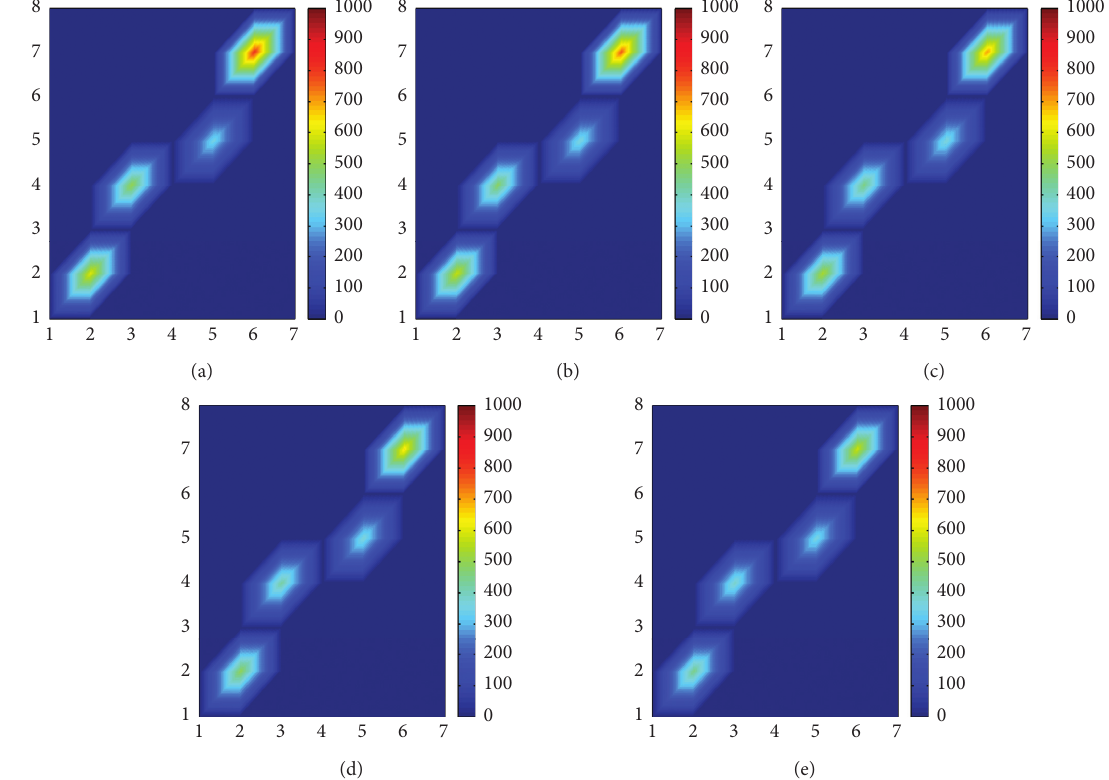
Figure 10: The biomass of prey behavior within Ω with control u C pq and v C pq . (a) t � 0. (b) t � 50. (c) t � 100. (d) t � 150. (e) t � 200.